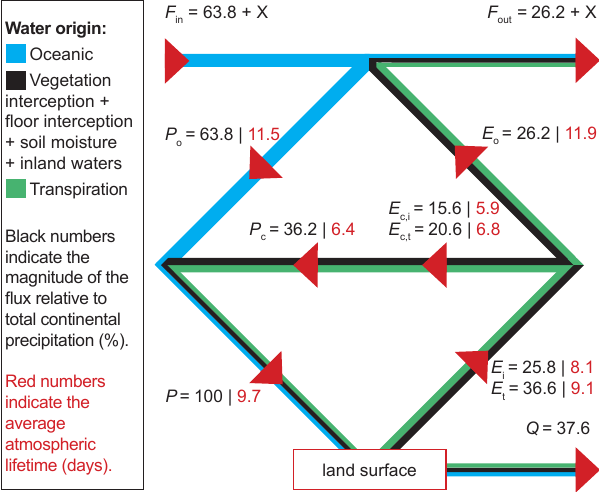
Figure 1. Global hydrological cycle over land, i.e. all continents considered together (1999–2008). F in is the atmospheric moisture of oceanic origin that crosses the ocean–land boundary and enters the atmosphere above land. F out is the atmospheric moisture that leaves the ocean–land boundary towards the ocean. Thus, X repre- sents the atmospheric moisture of oceanic origin that passes through the continental atmosphere, but never precipitates. Precipitation on land P (set to 100%) is composed of moisture evaporated from the ocean P o and a recycled part P c . On the land surface, water runs off Q , or evaporates through direct evaporation E i or through tran- spiration E t . Part of this evaporation is lost to the ocean E o , while other parts of the evaporation recycle E c,i and E c,t . Evaporation data are from STEAM (Part1), precipitation data are from ERA-I, the recycled fractions and lifetimes are calculated by WAM-2layers (Appendix B), and the other terms follow from the water balance. Symbols are further explained in Sects. 2.2.1 and 3.1.